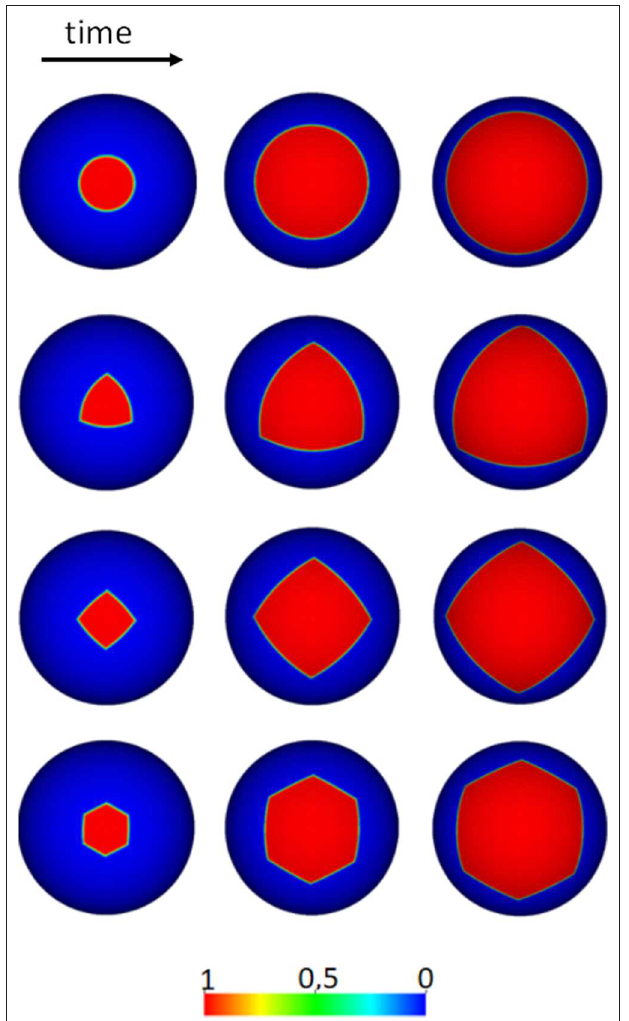
FIGURE 2 | Isothermal crystallization on spheres. This figure shows the isothermal growth of initial circular nuclei on spheres (time flows from left to right), for different surface tension anisotropy. From top to bottom the different rows show the evolution of nuclei for anisotropies n n 6. At the bottom we show the color map of the order parameter φ . =